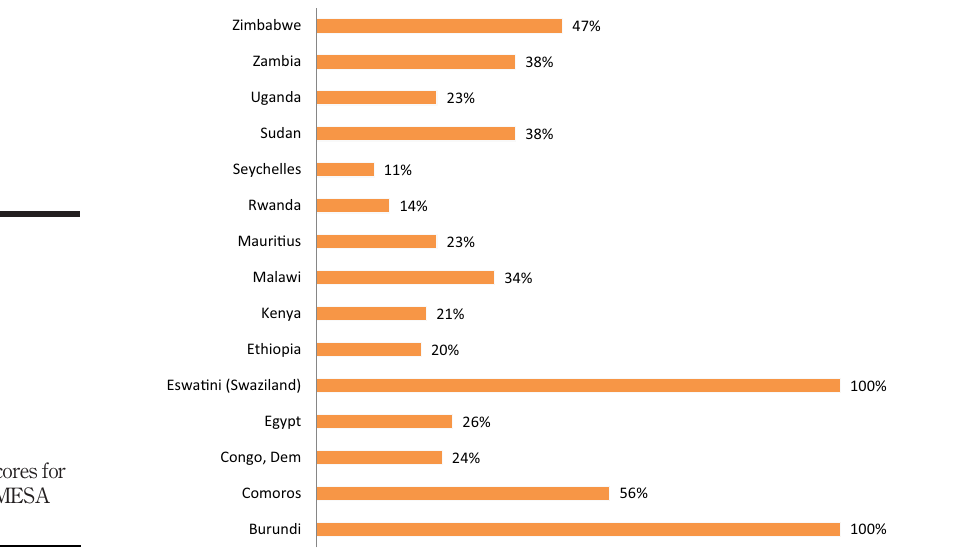
Figure 3. Ef fi ciency scores for selected COMESA